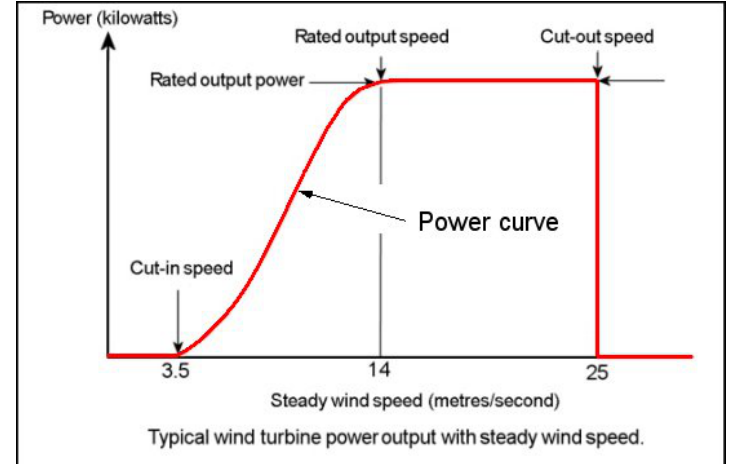
Figure 6. Wind power vs. wind speed